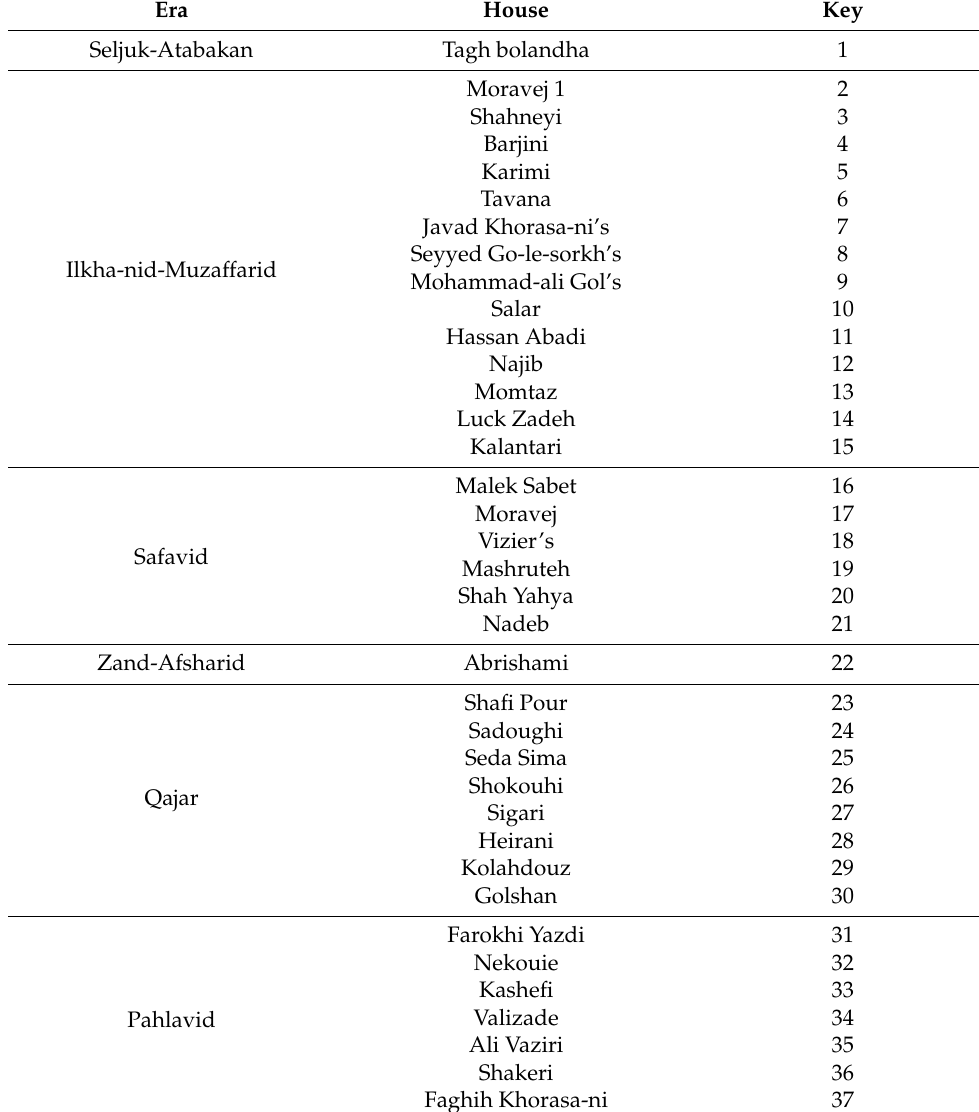
Table 1. Complete list of cases by ERA, and Key to Figure 3. Era House